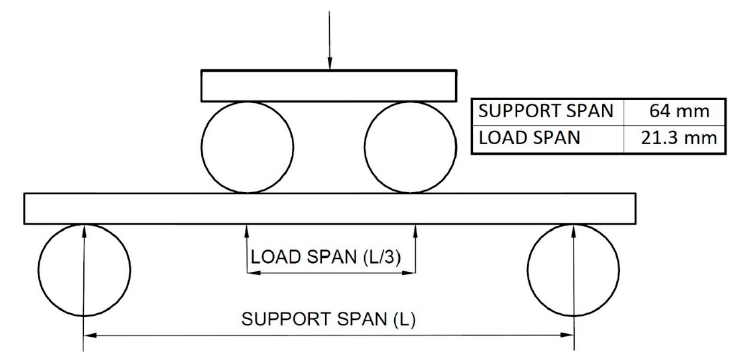
Figure 5. Diagram of the four-point bending test method, according to the D6272-02 ASTM standard.